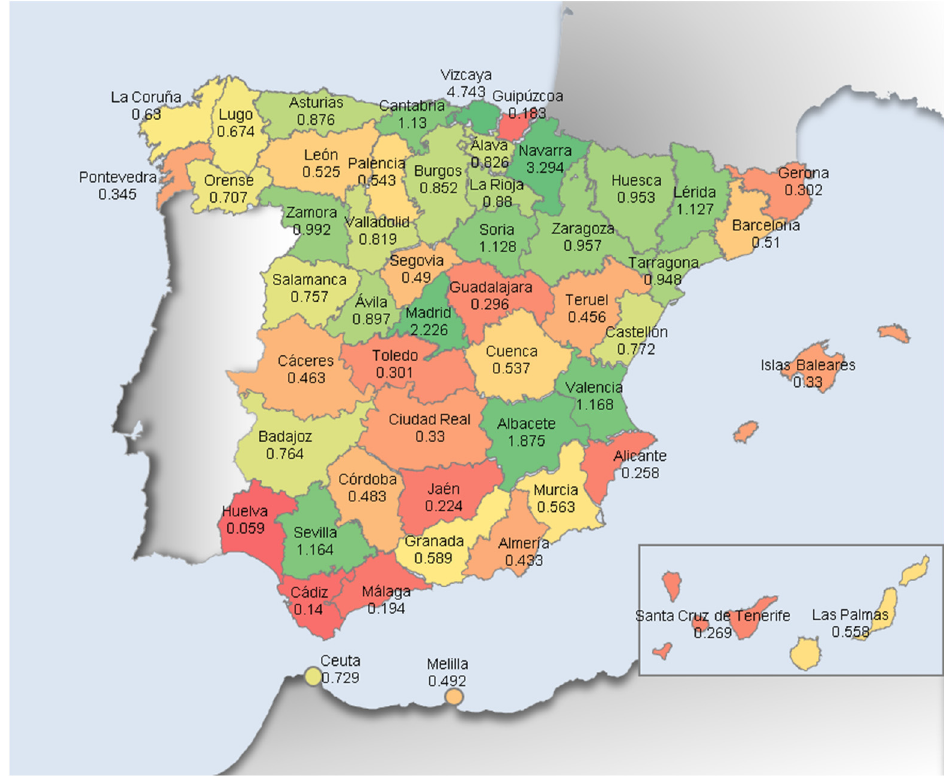
Figure 2. Degree of agglomeration of employment in the sector at the provincial level in Spain.